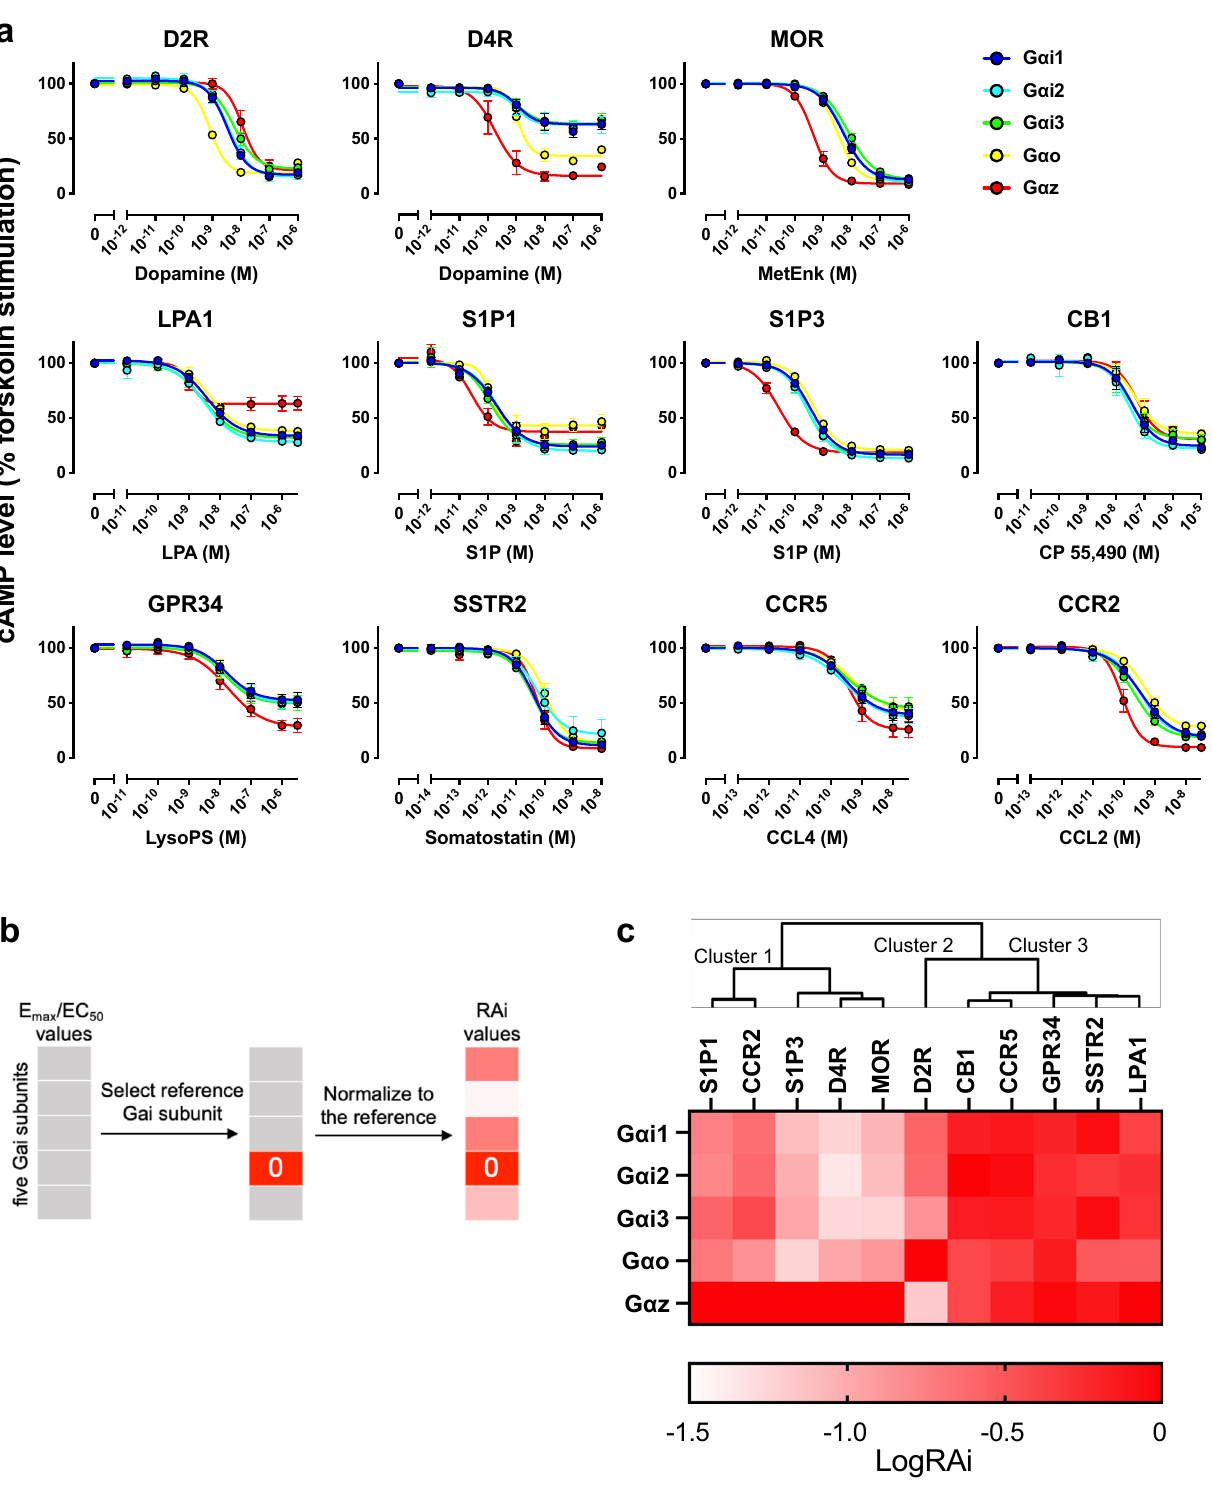
Fig. 4 G α i subunit-coupling pro fi le in Δ G α i cells as determined by GloSensor cAMP assay. a Concentration – response curves of GloSensor cAMP assays in the Δ G α i cells transiently expressing Glo-22F with certain combinations of GPCR and G α i subunits. Cells were stimulated with 10 µ M forskolin along with the indicated concentrations of ligands. For each experiment, forskolin-induced cAMP accumulation was set as 100%. In all fi gures, symbols and error bars represent the mean and SEM, respectively, of three independent experiments. Each experiment was performed in triplicate. Note that for some data points, error bars are smaller than the size of symbols. b Schematic diagram showing the process for calculating RAi values. c Heatmap of the LogRAi values for the 11 GPCRs. Colors range from white (LogRAi = − 1.5) to red (LogRAi = 0). Receptors are arranged according to the dendrogram of the hierarchical clustering, which was calculated from the coupling pro fi